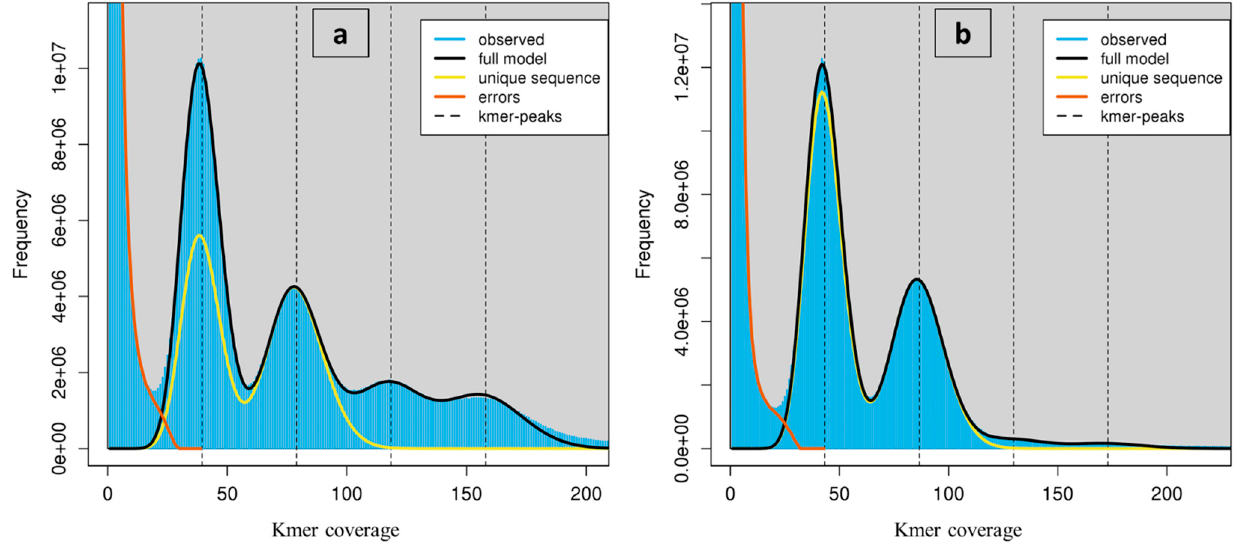
Figure 7. K-mer profile ( k = 41) spectrum analysis to estimate genome size in Reseda lutea ( a ) and Reseda pentagyna ( b ) generated from sequence data using GenomeScope V1. The high peak at quite low depths, induced by sequencing errors, has been trimmed to empower visualization. Table 5. Genome properties of Reseda lutea and Reseda pentagyna.